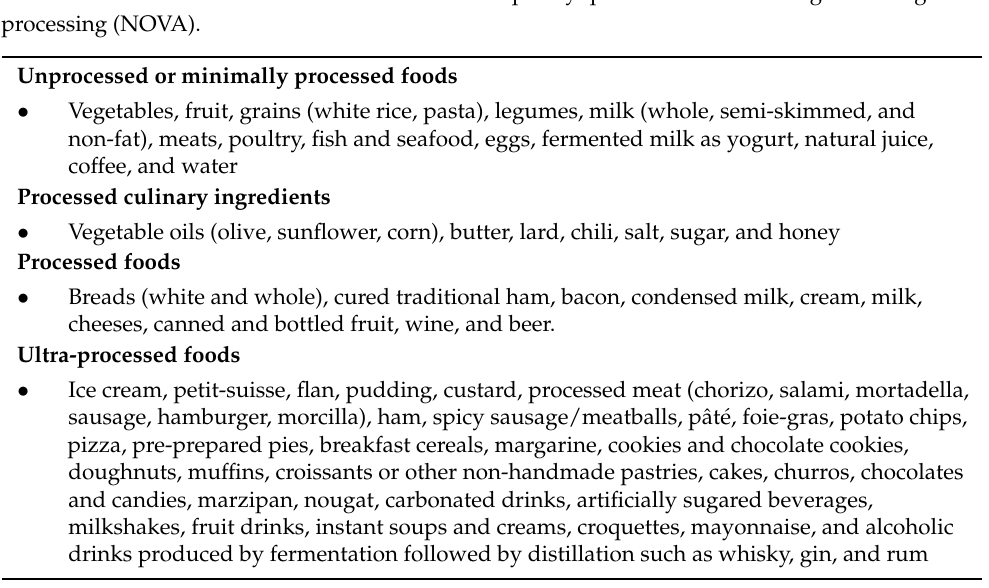
Table 1. Classification of foods in the SUN food frequency questionnaire according to the degree of processing